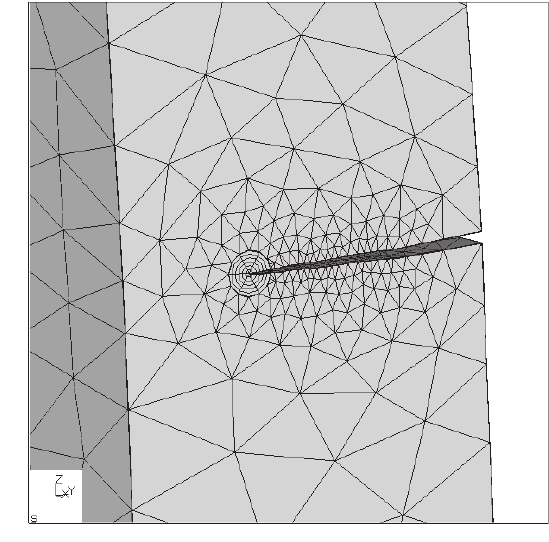
Figure 5: Mesh at the crack